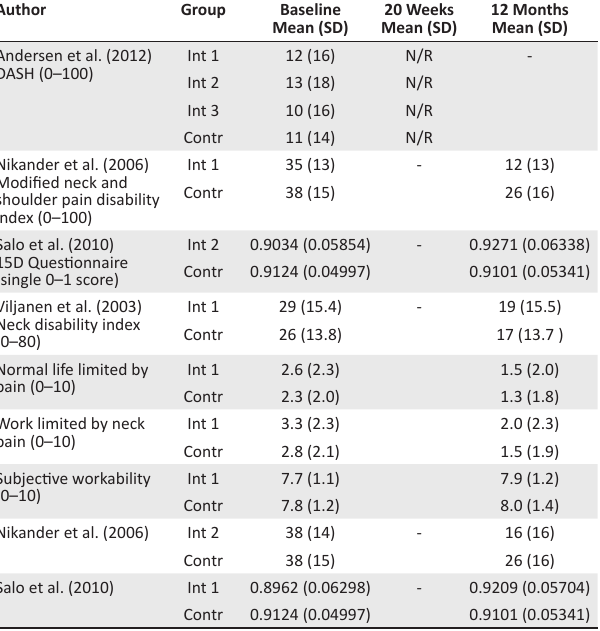
TABLE 6: The baseline and follow-up values for quality of life scores of studies incorporating strengthening or endurance exercise as an intervention compared to their respective